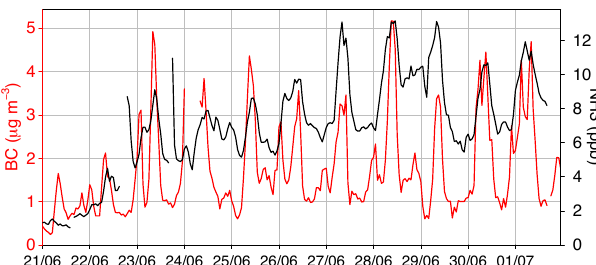
Figure 6. Observed BC (in red) and NH 3 (in black) hourly concen- trations at LHVP during the end of